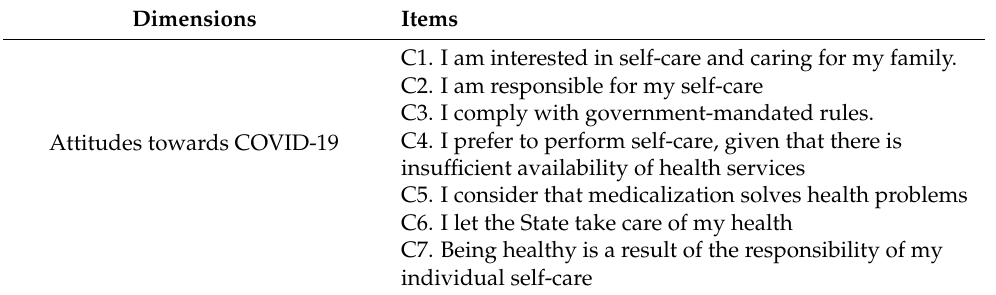
Table 3. Questionnaire of attitudes towards